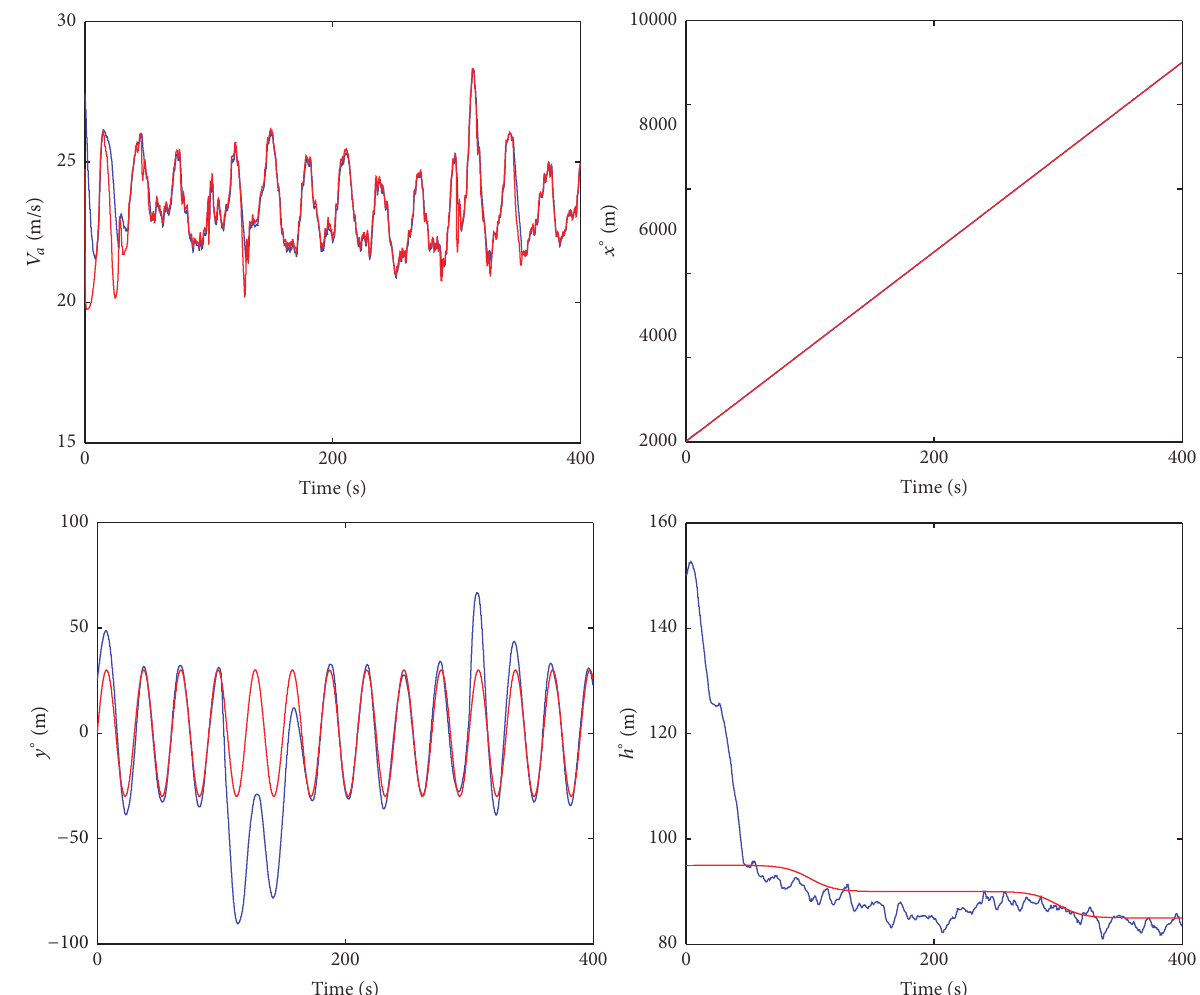
Figure 3: Time responses of the air velocity ( 𝑉 𝑎 ), range ( 𝑥 𝑜 ), inertial lateral displacement ( 𝑦 𝑜 ), and altitude ( ℎ 𝑜 ) (blue line) compared with their reference (red)